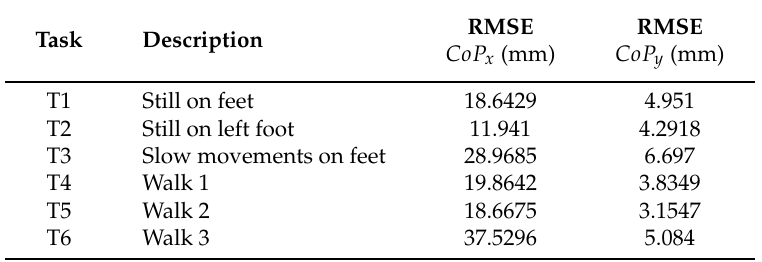
Table 3. Root mean square error (RMSE) analysisof centre of pressure CoP x , CoP y (mm), respectively, from tasks T1 to T6.